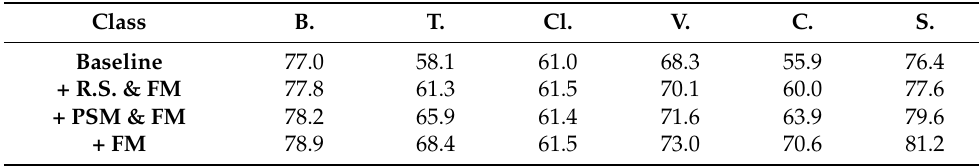
Table 8. Segmentation performance measured in IoU(%) on